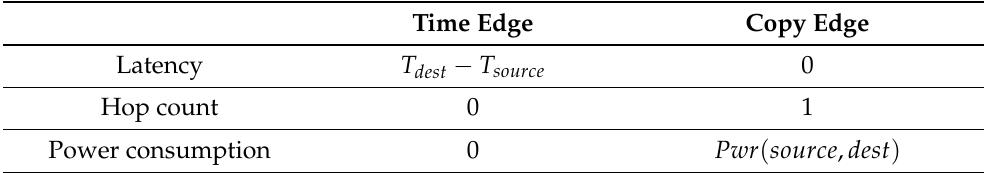
Table 2. Immediate edge costs R for rl4dtn for various distance